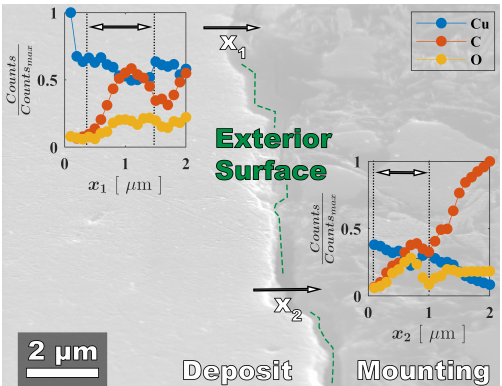
Figure A1. EDS line scans across the upper, exterior surface of the deposit. The deposit occupies the left of the figure, the mounting media the right. The exterior surface is marked with a green dashed line. The positions of two example EDS scans are marked with arrows across the exterior surface (labeled x 1 and x 2 ). The relative intensities of the elements, determined from the EDS spectra collected at each point within the scan, are plotted in two insets. The legend for the elements is in the upper right corner of the figure. The black dotted lines on the line scans indicate the approximate limits of the contamination on the exterior